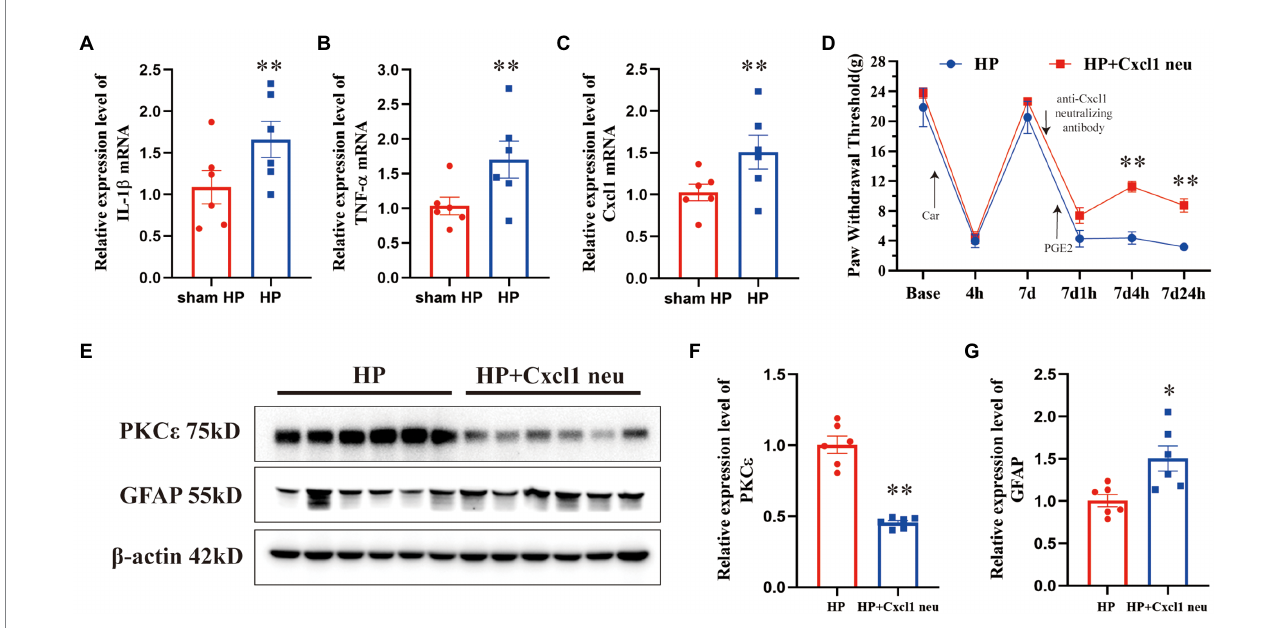
FIGURE 5 CXCL1 in the ipsilateral DRG plays a pivotal role in pain transition in HP model. The upregulation of IL-1 β (A) , TNF- α (B) , and CXCL1 (C) was validated by qPCR. n = 6 rats per group. (D) Injection of an anti-CXCL1 antibody into the L5 DRG before PGE2 injection increased the pain thresholds of HP model rats 4 and 24 h but not 1 h after PGE2 injection. Representative Western blot showing PKC ε (E, F) and GFAP (E, G) protein expression in the DRG 24 h after PGE2 injection and quantification of the Western blots results. * p < 0.05, ** p <